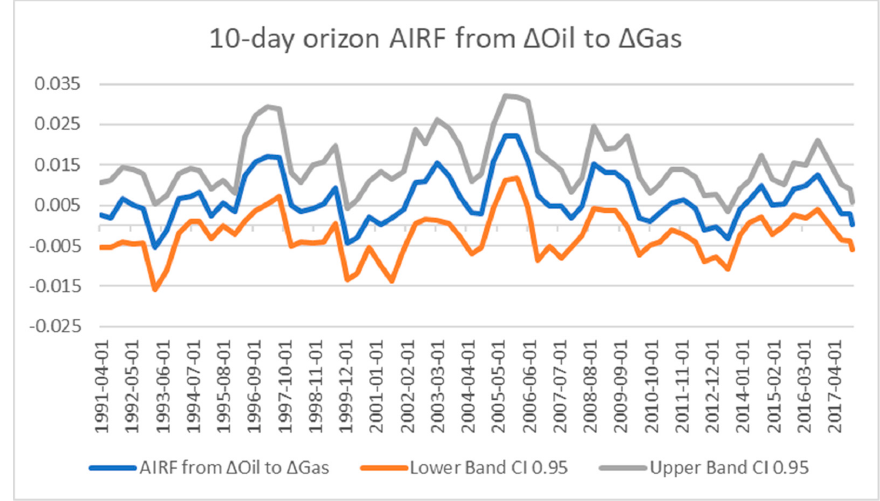
Figure 8. 10-day horizon AIRF from Oil to Gas (in %).